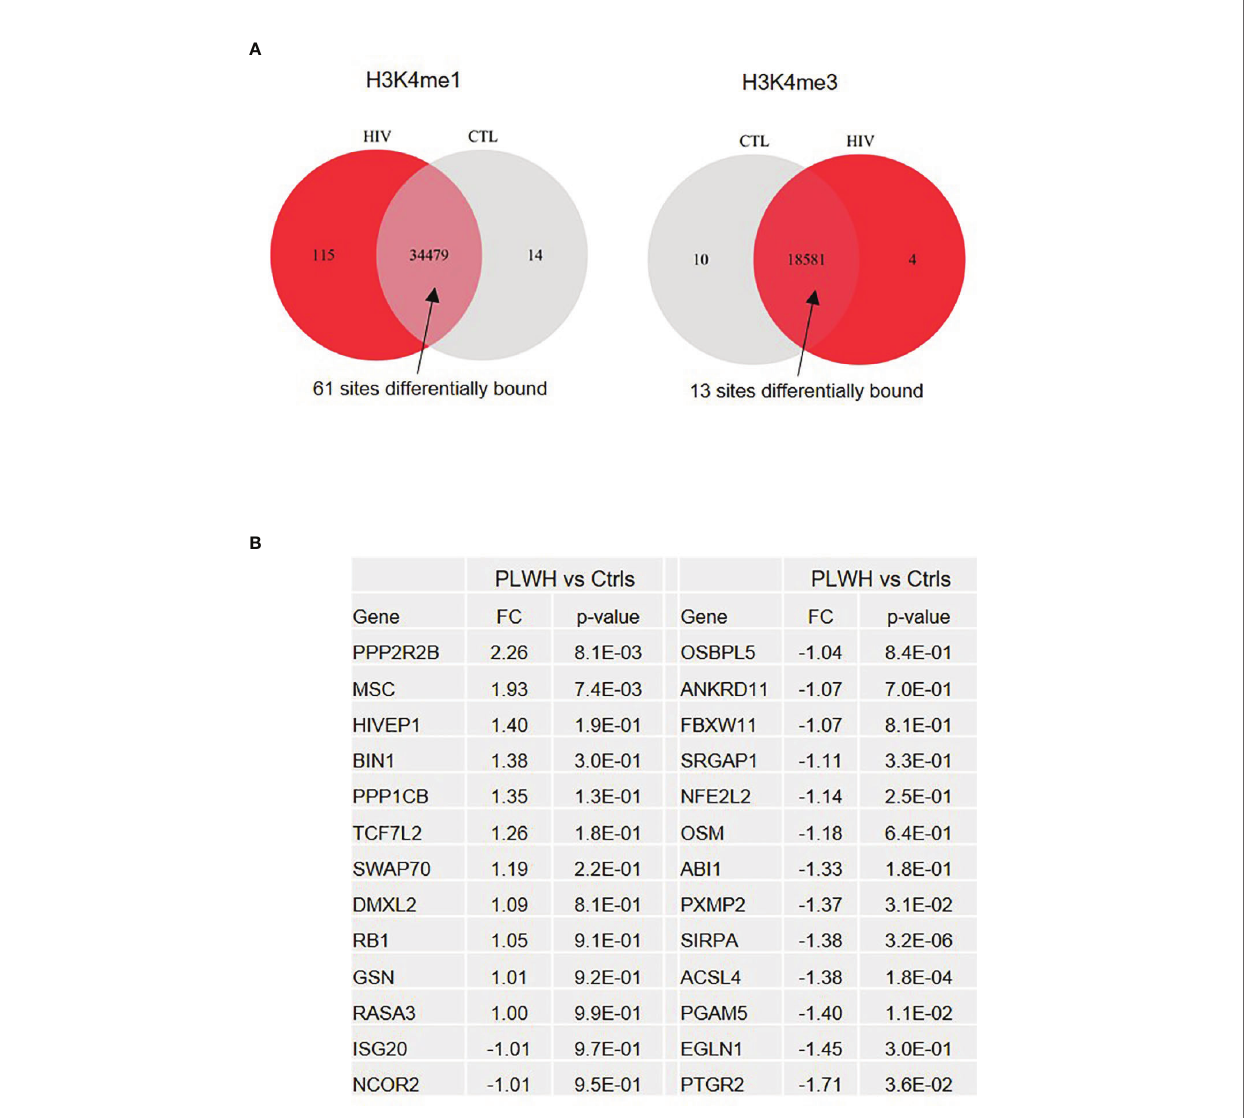
FIGURE 2 | ChIP-sequencing reveals genes differentially expressed in freshly isolated monocytes from PLWH compared to controls. (A) Venn diagram showing the number of sites enriched in H3K4me1 and H3K4me3 marks uniquely found in PLWH and controls, as well as those at sites common in both sets of samples (Ctrl n=3; PLWH n=6). Note that the unique sites in one group means that they were present in all the samples from that group and absent in all samples of the other. A false discovery rate (FDR) < 0.05 was applied. (B) List of 26 differentially expressed genes in freshly isolated monocytes from PLWH (n=25). Relative quanti fi cation was calculated over controls (Ctrls, n=10) T0. For the complete list of genes, see the Excel fi le provided in Supplementary Material